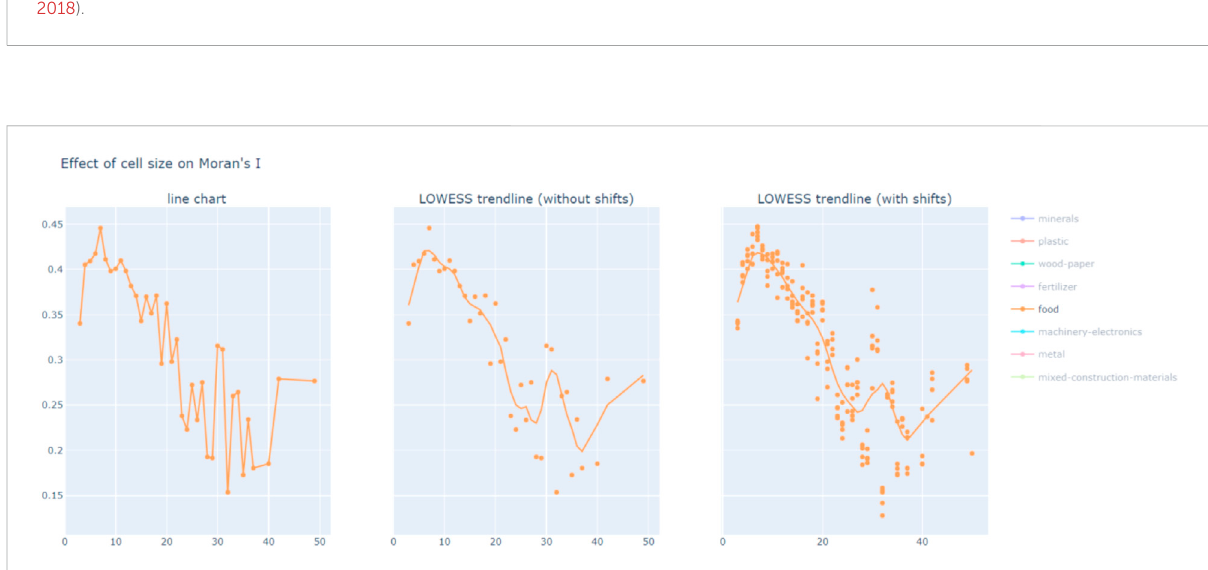
FIGURE 5 Creating the LOWESS trendline that shows cell sizes with strongest spatial clustering for food reuse. Charts created by